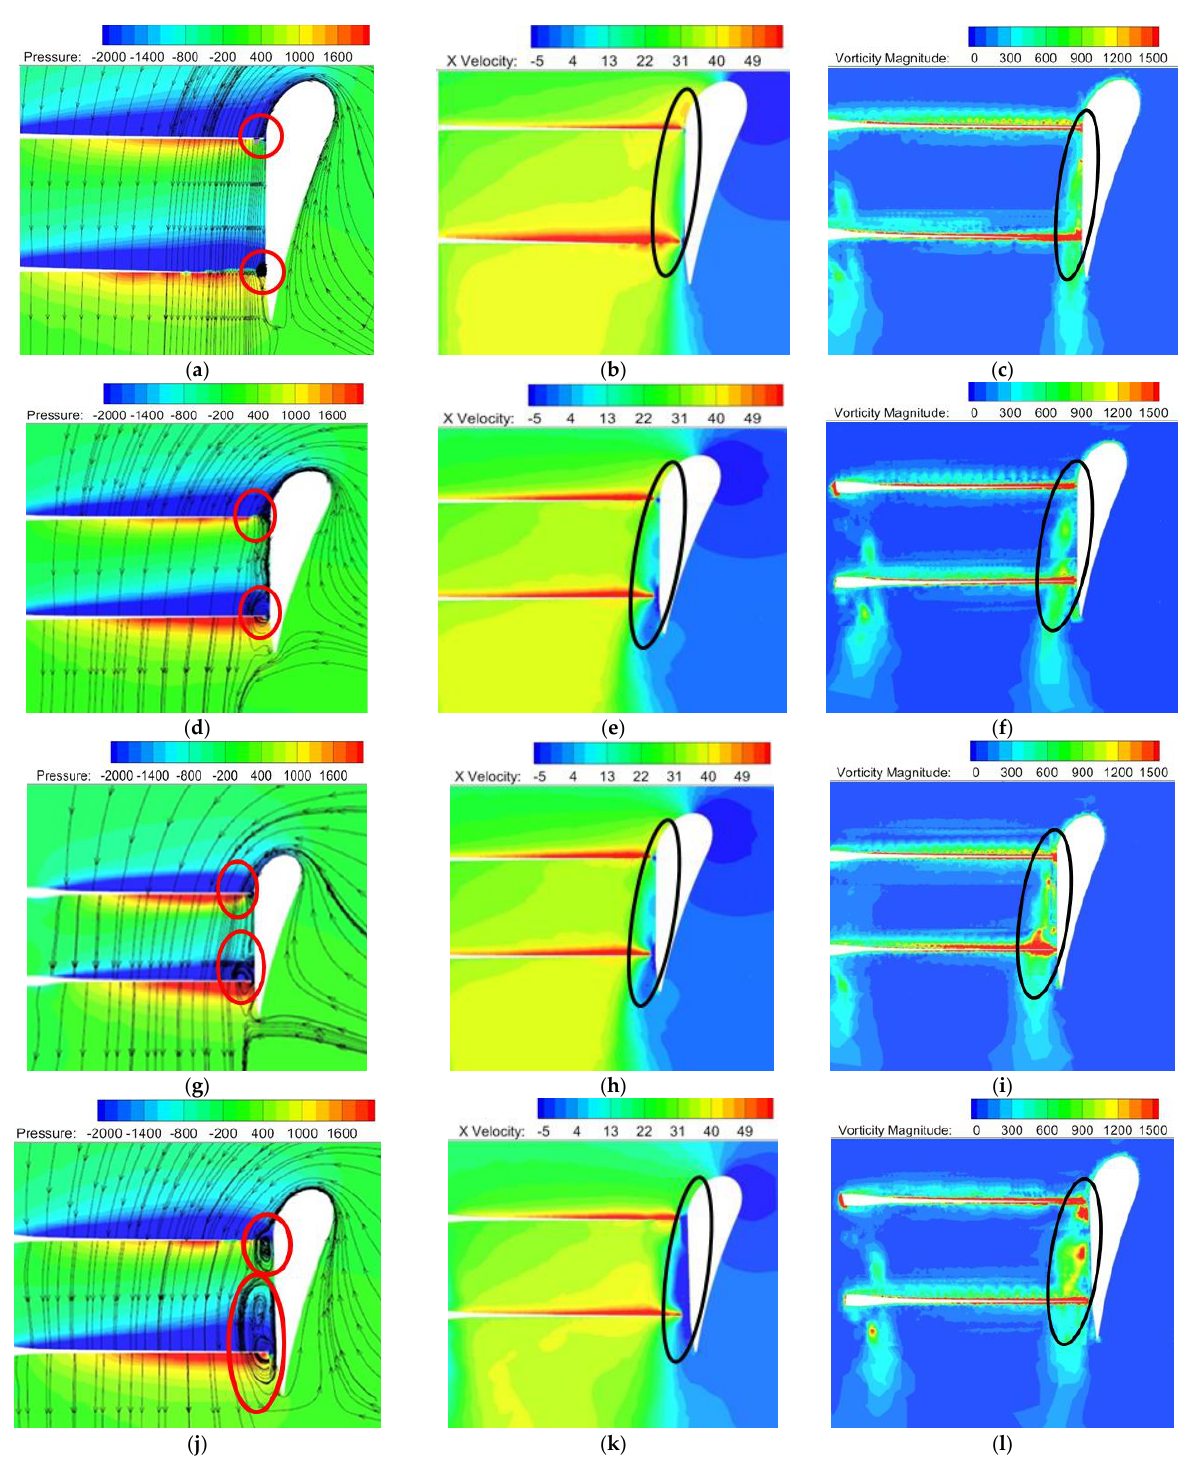
Figure 12. Flow field of flow separation, the red circles indicat the tip vortex, the balck circles indicat the flow separation: ( a ) streamline diagram and pressure field ( δ /R = 0.336%); ( b ) axial induced velocity field ( δ /R = 0.336%); ( c ) vorticity field ( δ /R = 0.336%); ( d ) streamline diagram and pressure field ( δ /R = 0.671%); ( e ) axial induced velocity field ( δ /R = 0.671%); ( f ) Vorticity field ( δ /R = 0.671%); ( g ) streamline diagram and pressure field ( δ /R = 1.007%); ( h ) axial induced velocity field ( δ /R = 1.007%); ( i ) vorticity field ( δ /R =1.007%); ( j ) streamline diagram and pressure field ( δ /R = 1.342%); ( k ) axial induced velocity field ( δ /R = 1.342%); ( l ) vorticity field ( δ /R =